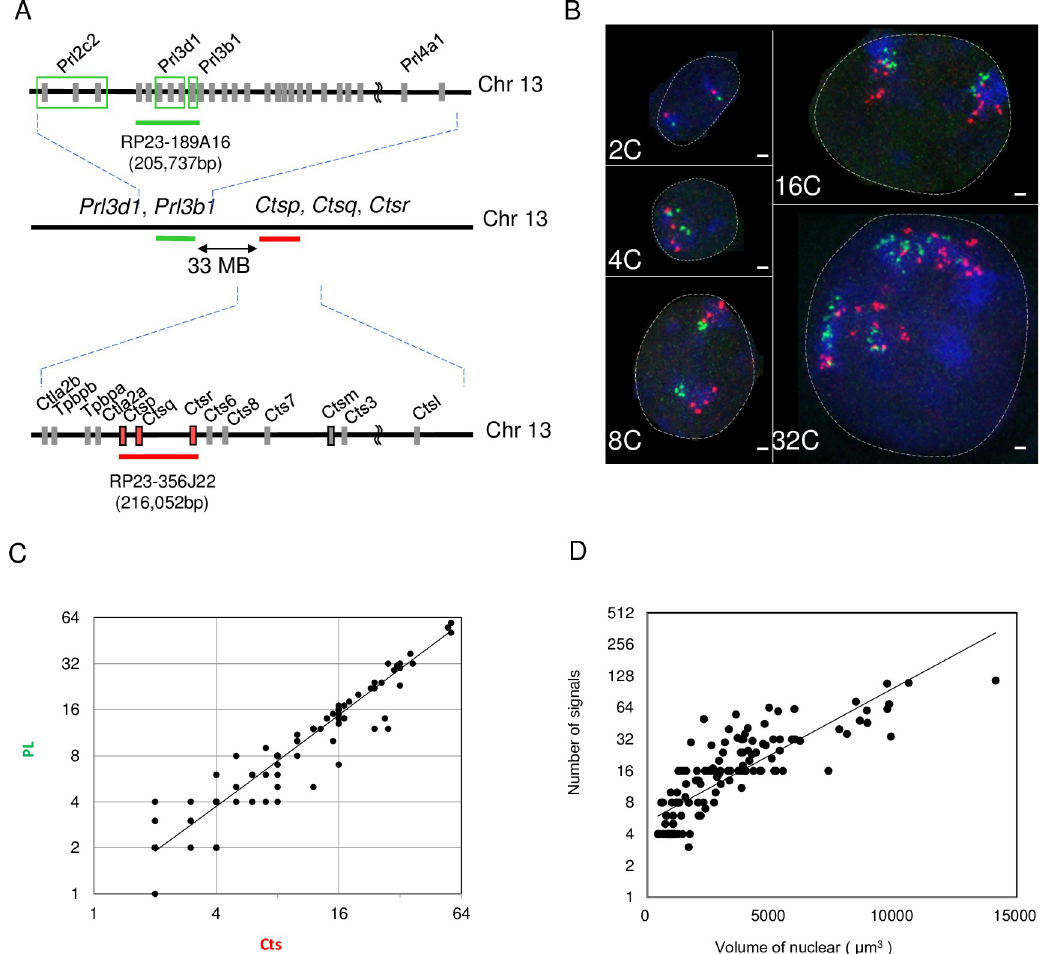
Fig 1. Visualization of Prl and Cts loci in TGCs. (A) Scale diagram of the Prl and Cts gene regions on chromosome 13. BAC clones to detect Prl and Cts loci are shown by green and red lines, respectively. (B) Arrangement of Prl and Cts loci in 2C TSC and 4C, 8C, 16C, and 32C TGCs. Bars mean 5 μ m. (C) Relationship between the numbers of Prl and Cts signals in a TGC nucleus. (D) Relationship between nuclear volume and numbers of Prl and Cts signals.